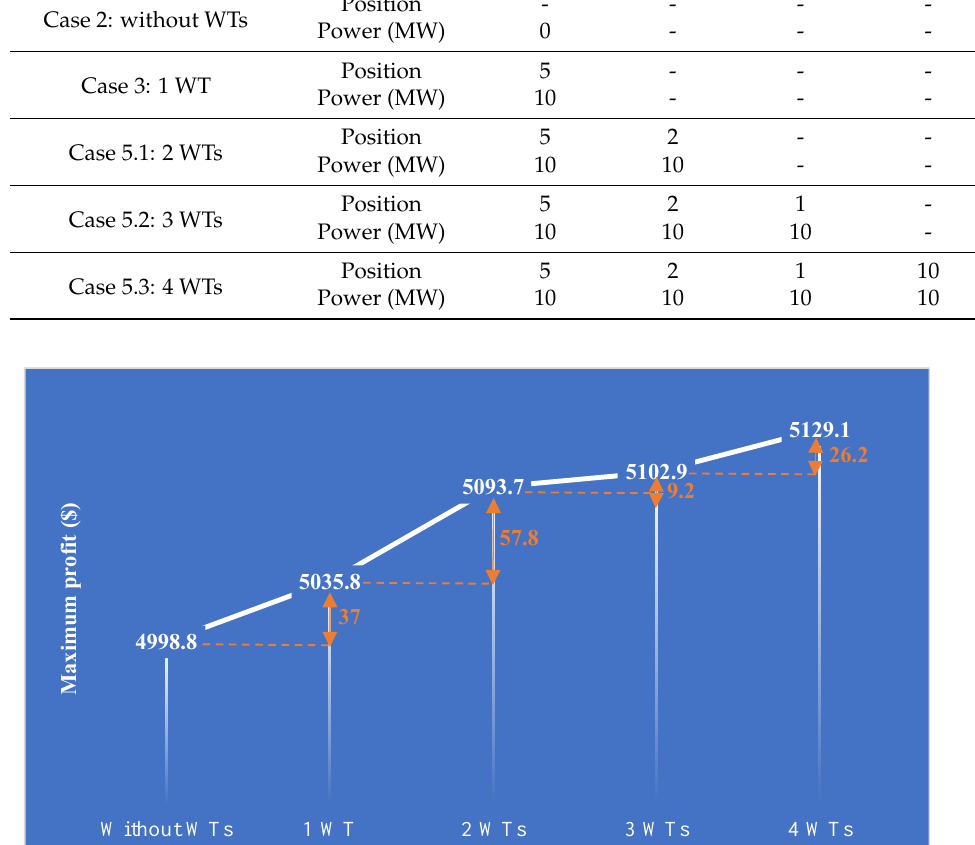
Figure 19. Comparison of profits from Case 2, Case 3, and Case 5.